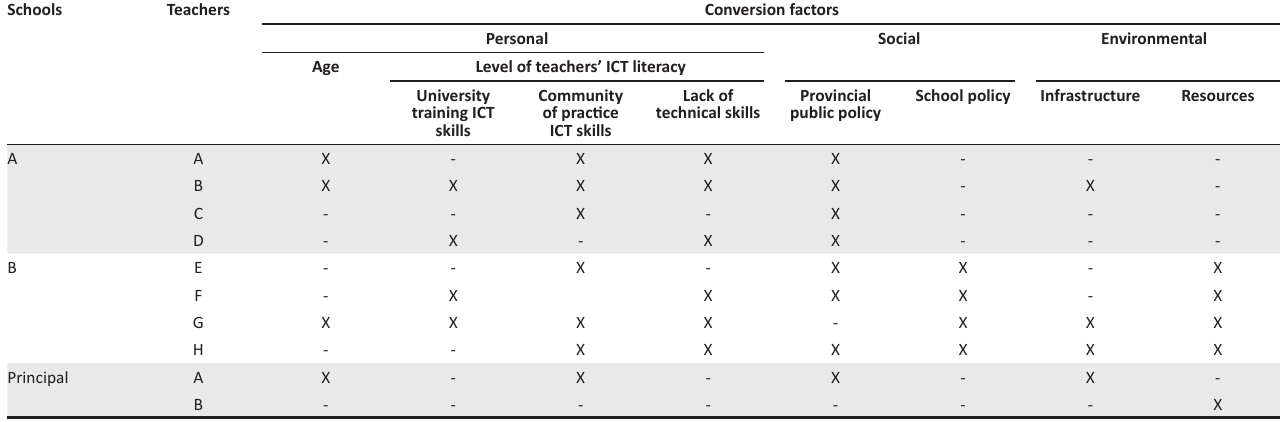
TABLE 1: Factors influencing teachers’